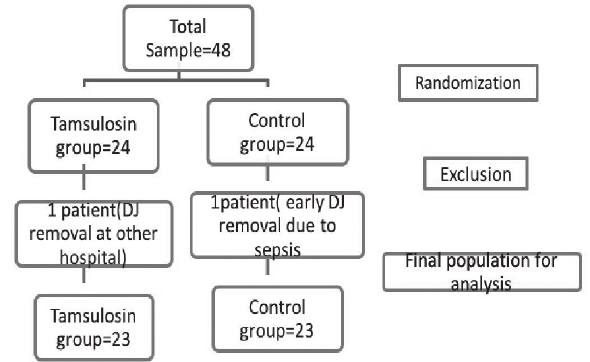
Figure 1: Consort diagram Table 1: Variables at the time of discharge